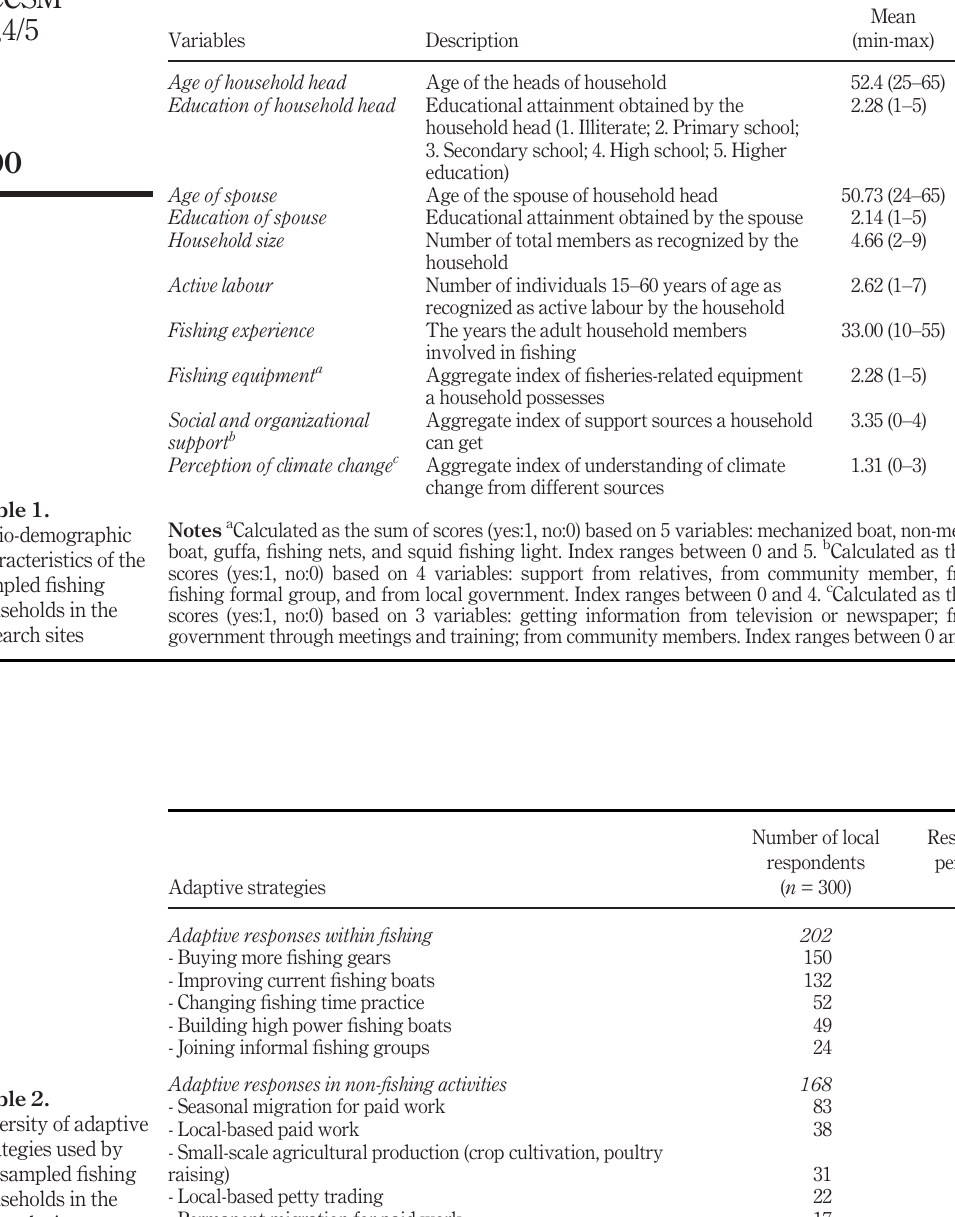
Table 2. Diversity of adaptive strategies used by the sampled fi shing households in the research sites over the past fi